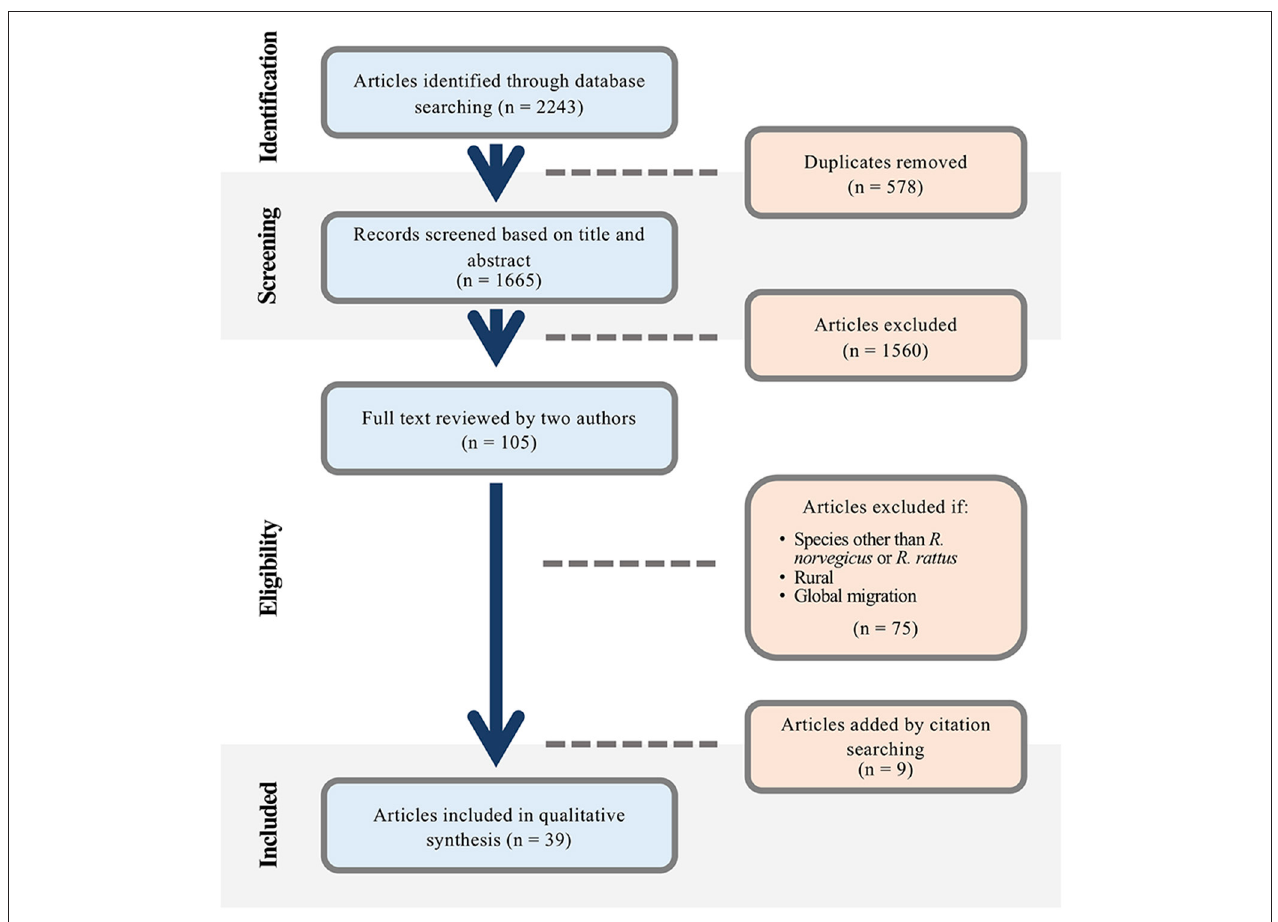
FIGURE 1 | Preferred Reporting Items for Systematic Reviews and Meta-Analyses (PRISMA) flow chart depicting the screening process of articles included in the narrative synthesis.